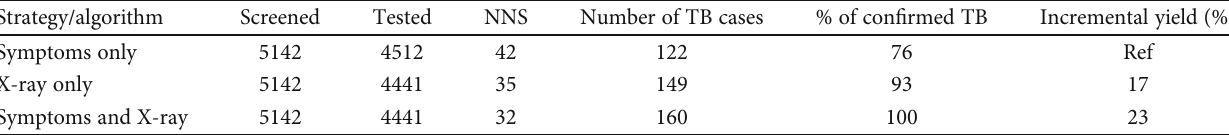
Table 3: Incremental yield and number needed to screen of using the CXR in a TB screening algorithm.